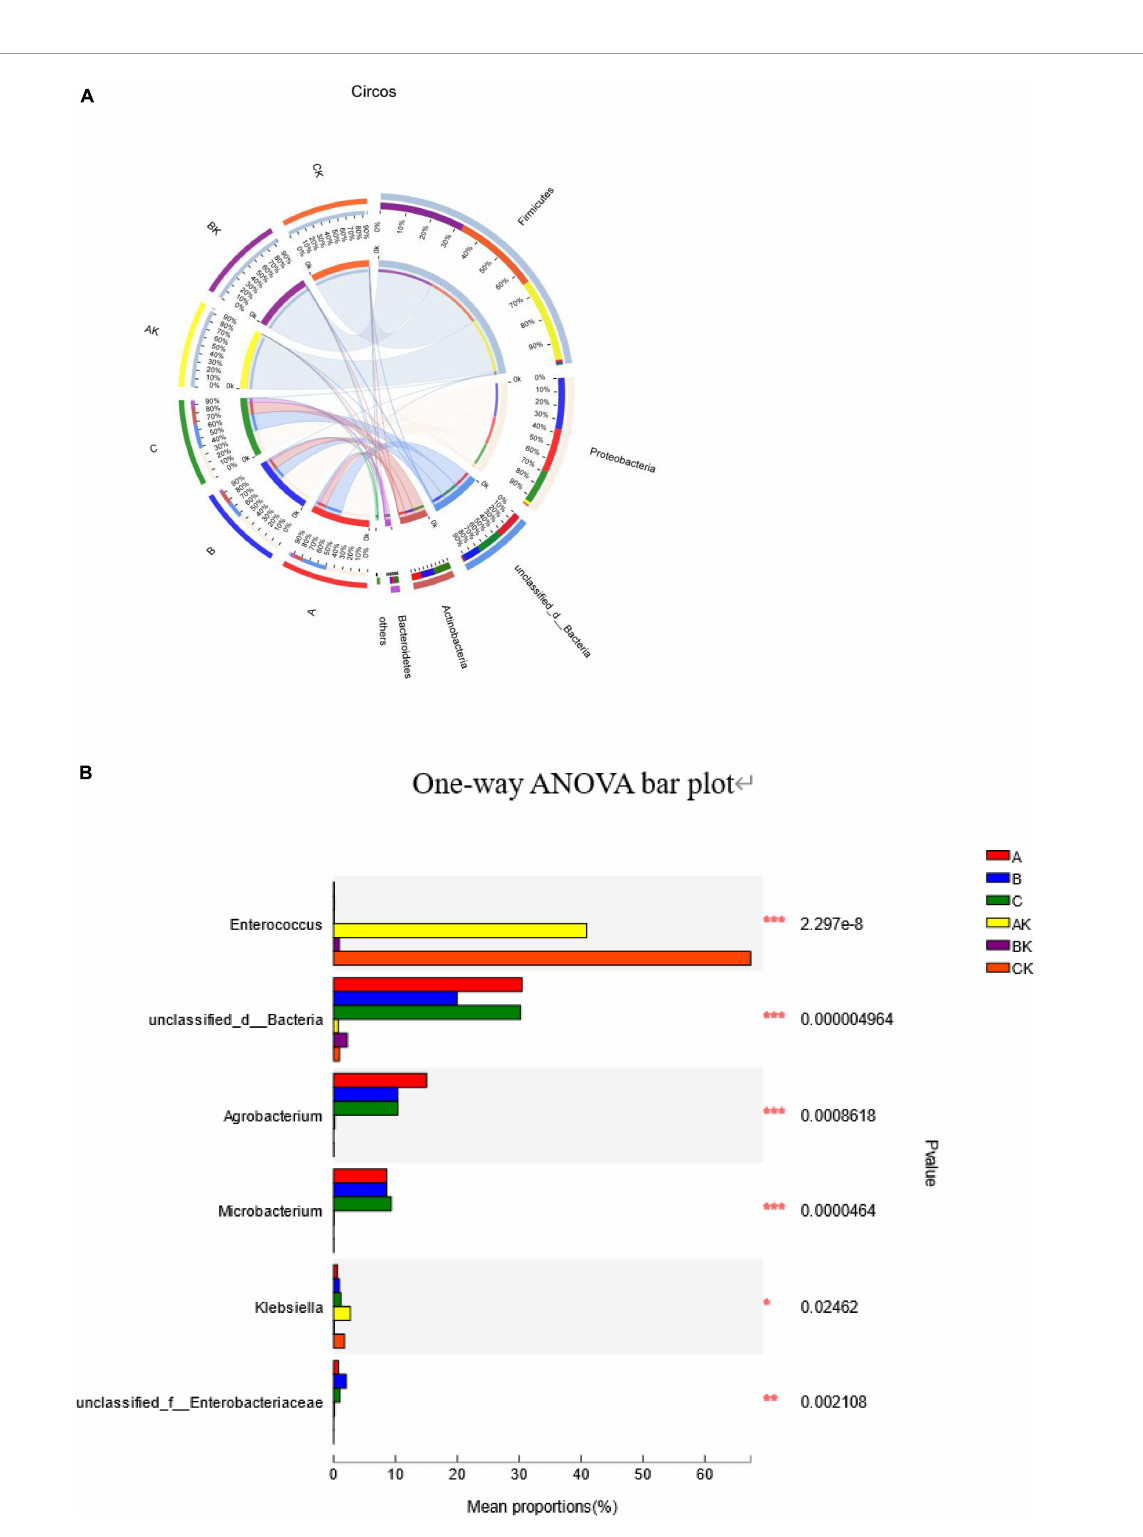
FIGURE3 Differences in the relative abundance of the microbial community at the phylum level shown by a Circos plot. The size of the bars from each phylum shows the relative abundance of that phylum in sample (A) . One-way analysis of variance bar plots at the genus level (10 most abundant genera) among the fresh and silage ryegrass. * p < 0.05; ** p < 0.01; *** p < 0.001 (B). A, first harvest of fresh ryegrass; B, second harvest of fresh ryegrass; C, third harvest of fresh ryegrass; AK, first harvest of ryegrass silage; BK, second harvest of ryegrass silage; CK, third harvest of ryegrass